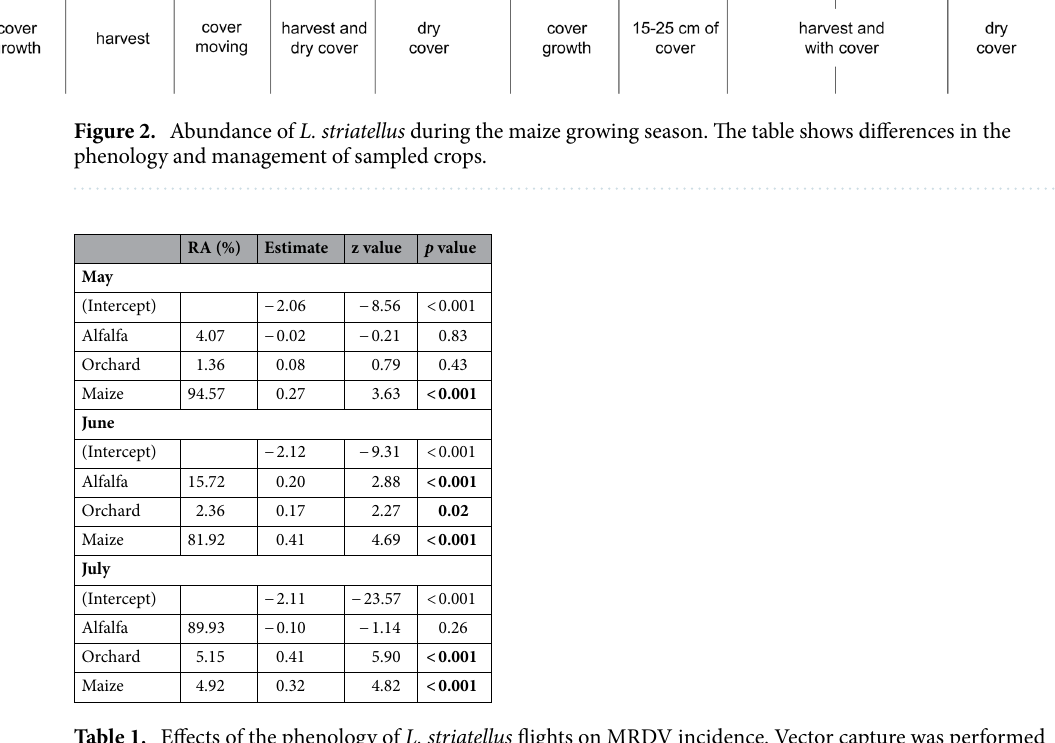
Table 1. Effects of the phenology of L. striatellus flights on MRDV incidence. Vector capture was performed in alfalfa fields, maize fields and orchards during the maize growing season. The models relating MRDV